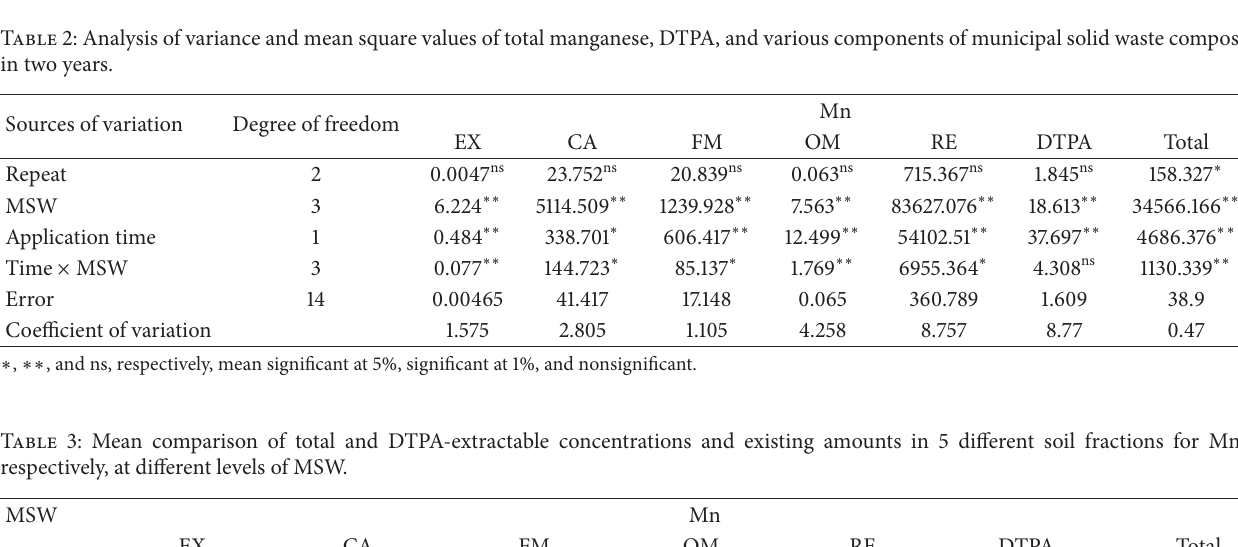
Available Available